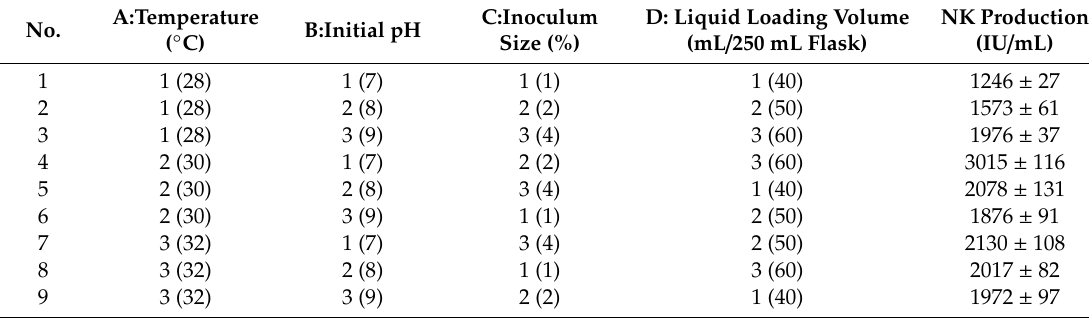
Table 3. Orthogonal array test to optimize fermentation condition for NK